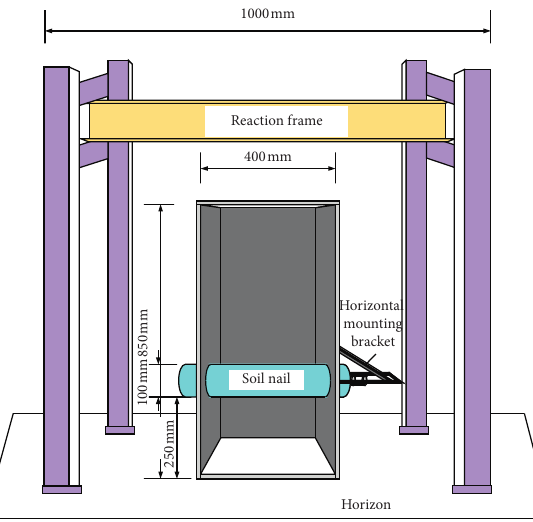
Figure 5: Schematic diagram of the model